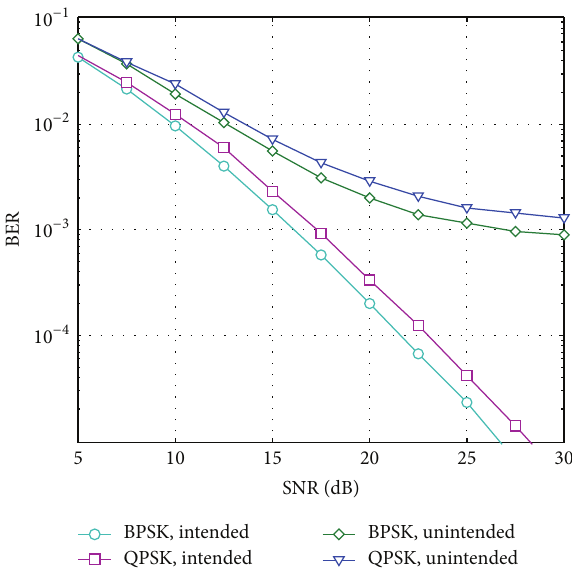
Figure 6: BER of the intended and unintended symbols for 𝑛 𝐸 = 2 and both BPSK and QPSK modulation